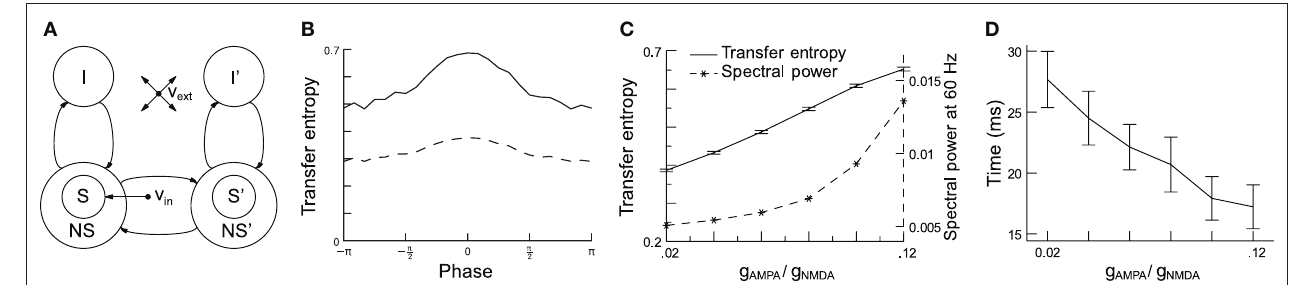
Figure 7 | increasing network gamma frequency band power leads to the more it differs from it. The solid line represents TE from neuronal pool 1 to mean transfer entropy (Te) increase and time for information transfer pool 2 (forward), the dashed line from pool 2 to pool 1 (backward). Forward TE is decrease. (A) Schematic representation of the network, which consists of two clearly stronger than backward TE. (C) When the conductance ratio g parts: in each part, there are excitatory (S, NS) and inhibitory (I) spiking neuron increases, both gamma power (dashed line) and TE (solid line) increase. (D) Rise pools, which are interconnected. The connectivity is full. The selective pool (S) times of TE as a function of the conductance ratio. Information starts flowing receives the external input ( ν ) and has strong recurrent connections. The two after stimulus onset when, consequently, TE starts rising. The plot shows the in parts of the network are connected via the selective pools by both feedforward time required to reach 50% of the average TE. TE clearly rises faster for higher and feedback connections. All neurons also get an input ( ν ) that simulates the gamma-band power. In both graphics, error bars indicate 95% confidence ext spontaneous activity in the surrounding cerebral cortex. (B) TE as a function of intervals; averaged over 100 trials. Figure modified from (Buehlmann and phase shifts and directionality. TE is highest for a 0 phase shift and gets lower